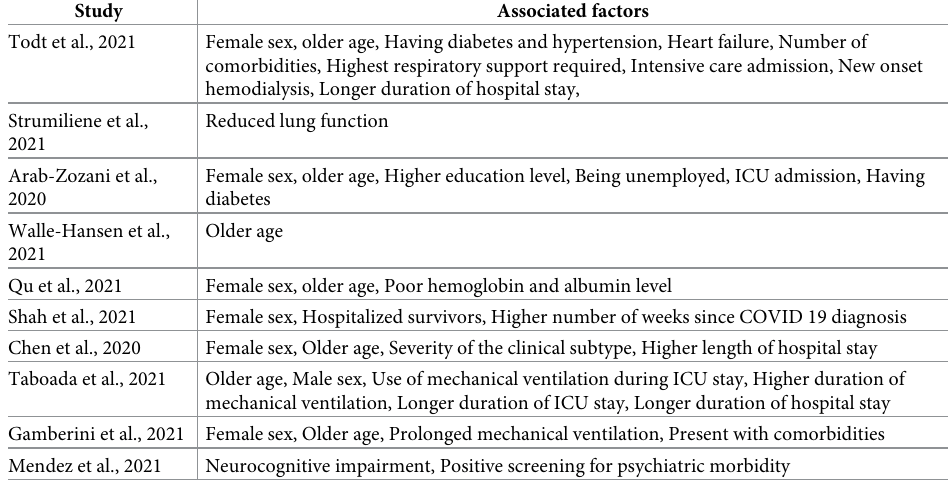
Table 3. Factors associated with the low levels of